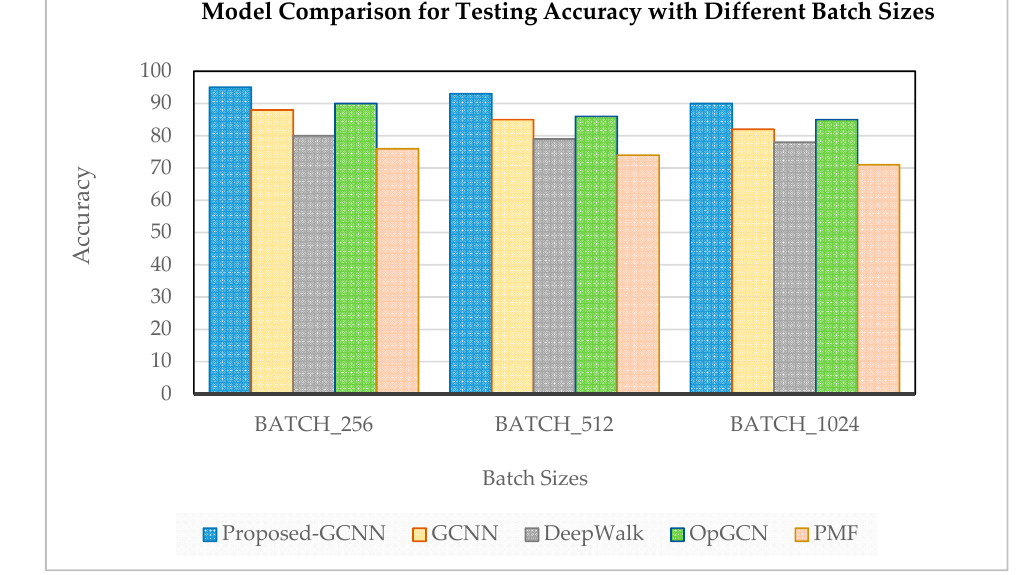
Figure 10. Testing accuracy for different batch sizes.